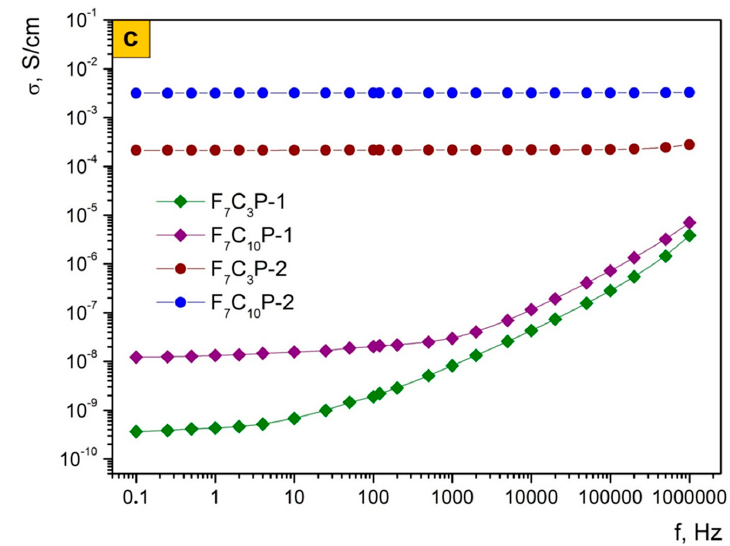
Figure 9. Frequency dependence of the conductivity for PDPAC, Fe 3 O 4 /SWCNT, and Fe 3 O 4 /SWCNT/PDPAC, prepared in alkaline ( a , c ) and acidic media ( b , c ). Table 3. The conductivity values of materials.